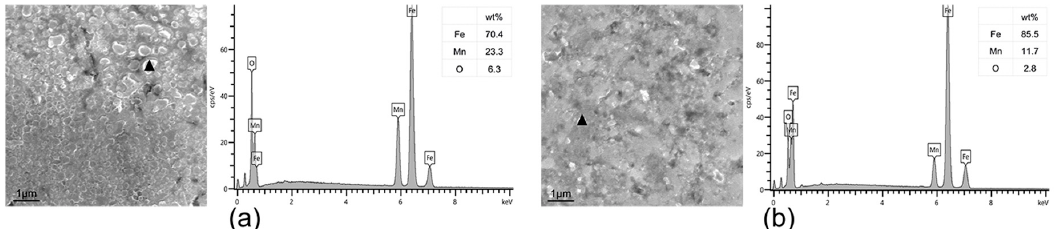
Figure 7. SEM micrographs and EDS analyses of surface oxides of samples annealed in different H 2 content atmospheres. ( a ) 2# (5% H 2 ), ( b ) 3# (20% H 2 ).